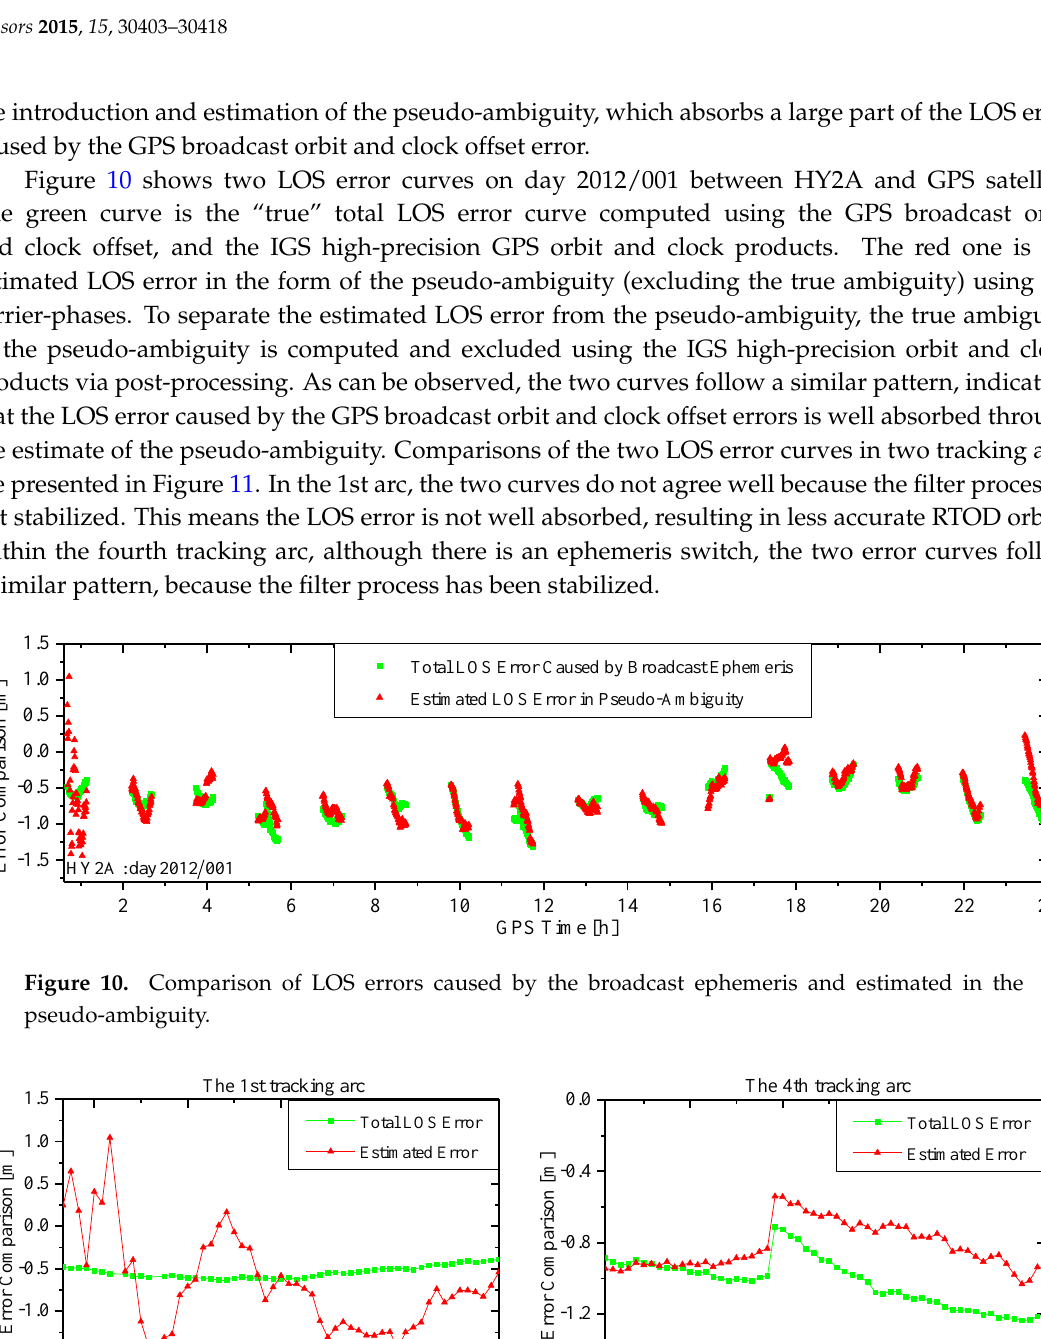
( d ) Figure 9. Orbit accuracy of the carrier-phase based solution s for ZY3 and GRACE-A. ( a ) Position accuracy of ZY3; ( b ) velocity accuracy of ZY3; ( c ) position accuracy of GRACE-A; and ( d ) velocity accuracy of GRACE-A.